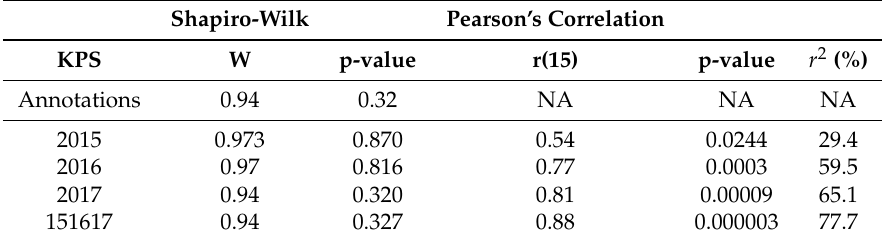
Figure 10. Four scatter plots of the R-FCN model KPS against annotation KPS with linear regression analysis computer for each. Table 5. Correlation analysis via Pearson’s correlation coefficient for the KPS of the four R-FCN models against the annotation KPS. Pearson’s assumes a normal distribution in the data which is evaluated through a Shapiro-Wilk normality